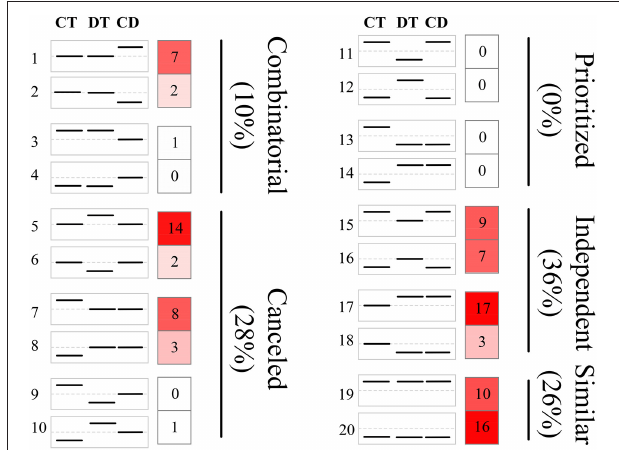
FIGURE 3 | Clustering of unigenes to predefined expression profiles generating the transcriptional response modes. The unigene sets were created by the union of the 500 most significant unigenes for CT, DT, and CD. These unigenes were clustered to 20 predefined expression profiles, each categorizing a potential expression change that may occur when combined stresses are applied. The dotted line in the boxes represents unigene expression with no change compared with the control. The value and color in the right boxes represents the percentage of unigenes that correlate with the particular predefined expression profile (red is higher). Combinatorial, similar levels in the CT and DT but a different response to CD; canceled, unigene response to either CT or DT returned to control levels; prioritized, opposing responses to the CT and DT and one stress response prioritized in response to CD; independent, response to only CT or DT and a similar response to CD; similar, similar responses to CT, DT, and CD.